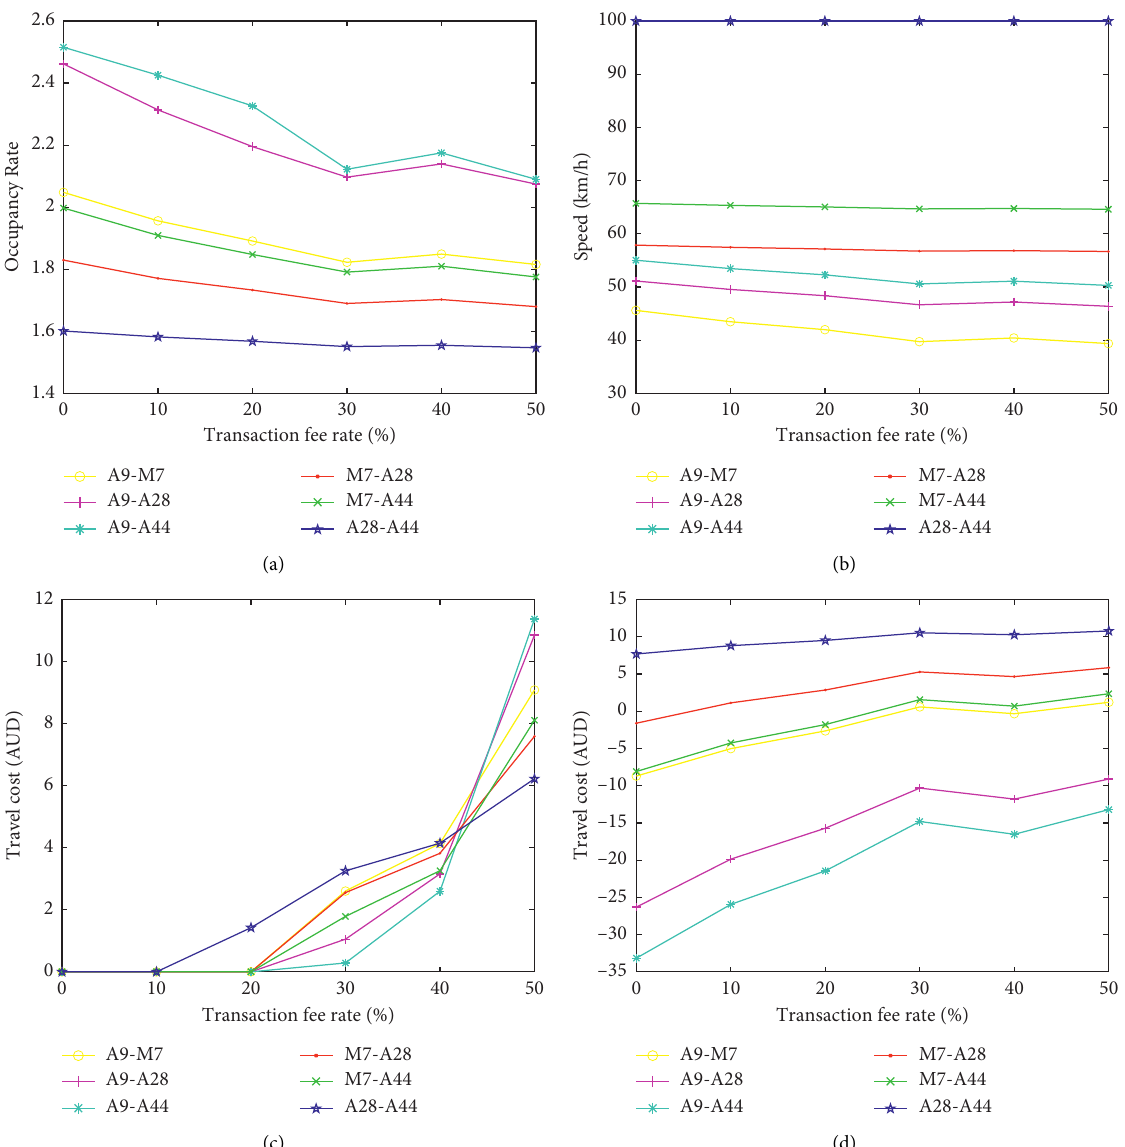
Figure 7: Detailed analysis about transaction fee rate for the 6 main ODs in the network. (a) Vehicle occupancy as a function of transaction fee rate. (b) Speed as a function of transaction fee rate. (c) Average RSP travel cost as a function of transaction fee rate. (d) Average RSD travel cost as a function of transaction fee rate.